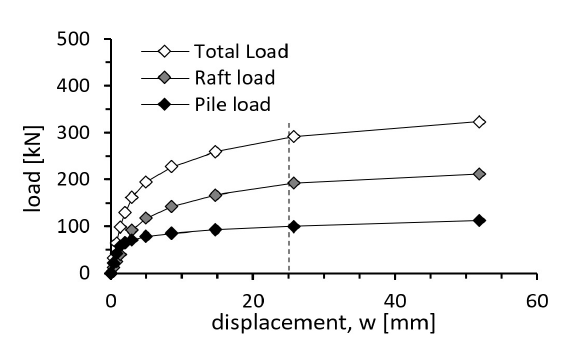
Figure 8. Load-settlement curve for case 1 - L=3m; t=0.1m